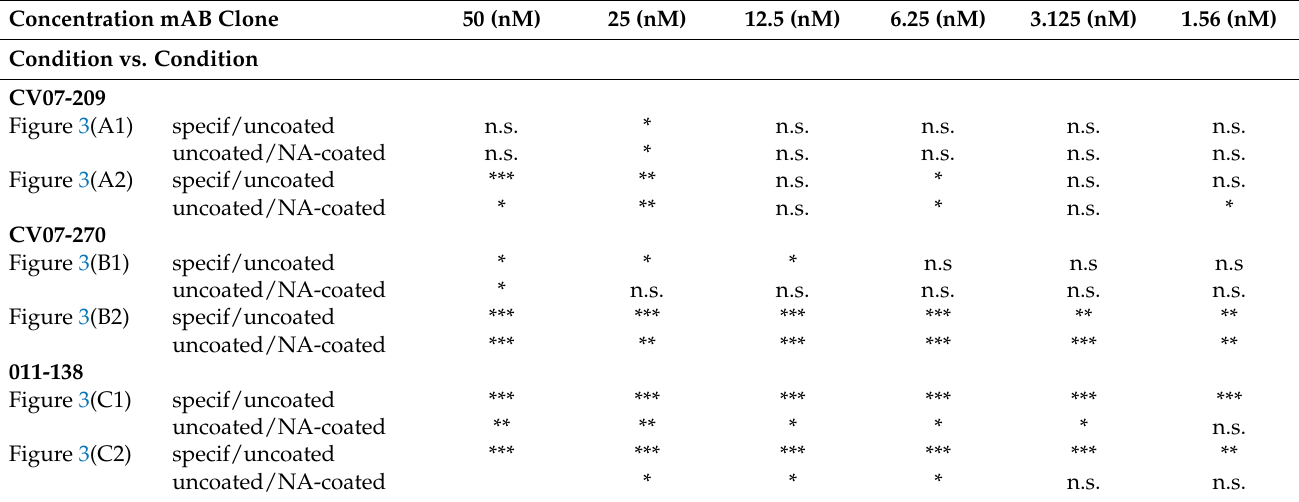
Table 2. Statistical evaluation of the binding of the single mAB clones onto immobilized BC 007 compared to control binding (NA-coated plate and uncoated activated plastic plate); values from Figure